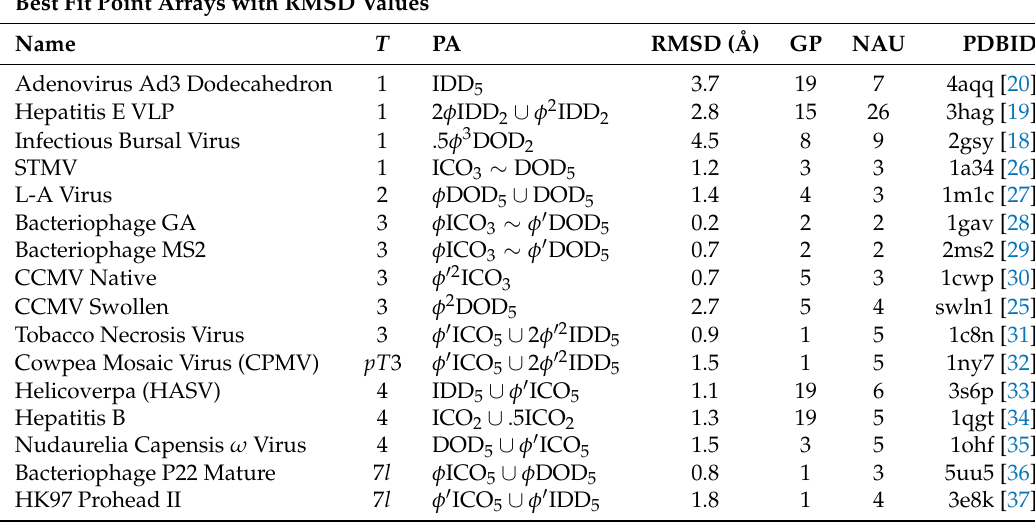
Table 3. Here we present the results of our fitness algorithm of 16 viruses, considering RMSD scores, gauge points (GP), and points of contact (NAU). All fits are decided as in Figure 9. Most RMSD fits are at least better than 0.5 Å than the next best array. Several viruses are equally well fit by a point array and its sister array. When both sister point arrays are equally valid, e.g., ICO 3 or DOD 5 of STMV, both are listed. If two point arrays are tied for best, that is stated explicitly. There are two cryo-EM fit solutions for CCMV (swln1) in the swollen state, we analyzed ccmvswln1 [25]. All structures analyzed in this paper were obtained from the Viper Database